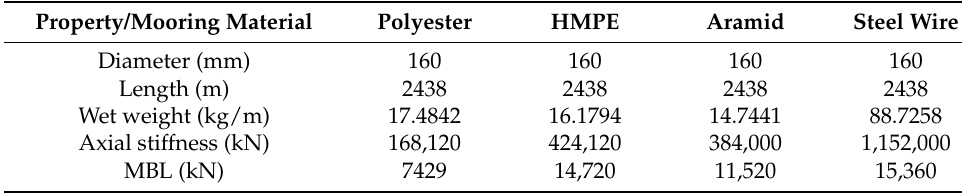
Table 5. Properties of mooring materials used in the study.